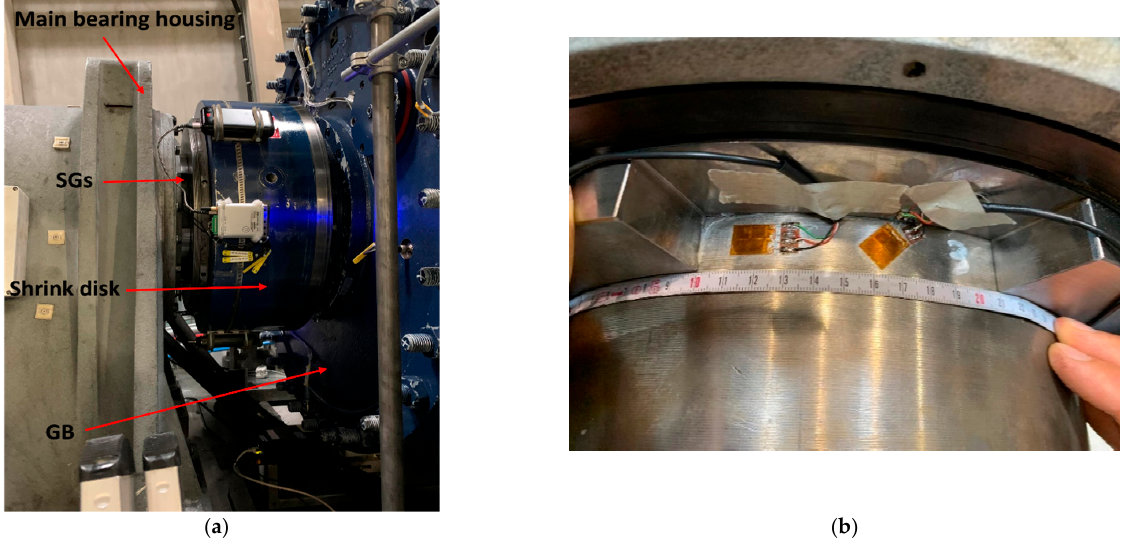
Figure 7. GB input (LSS) of the 4-point drivetrain ( a ) with limited space on the LSS and close-up of the SG location ( b ).